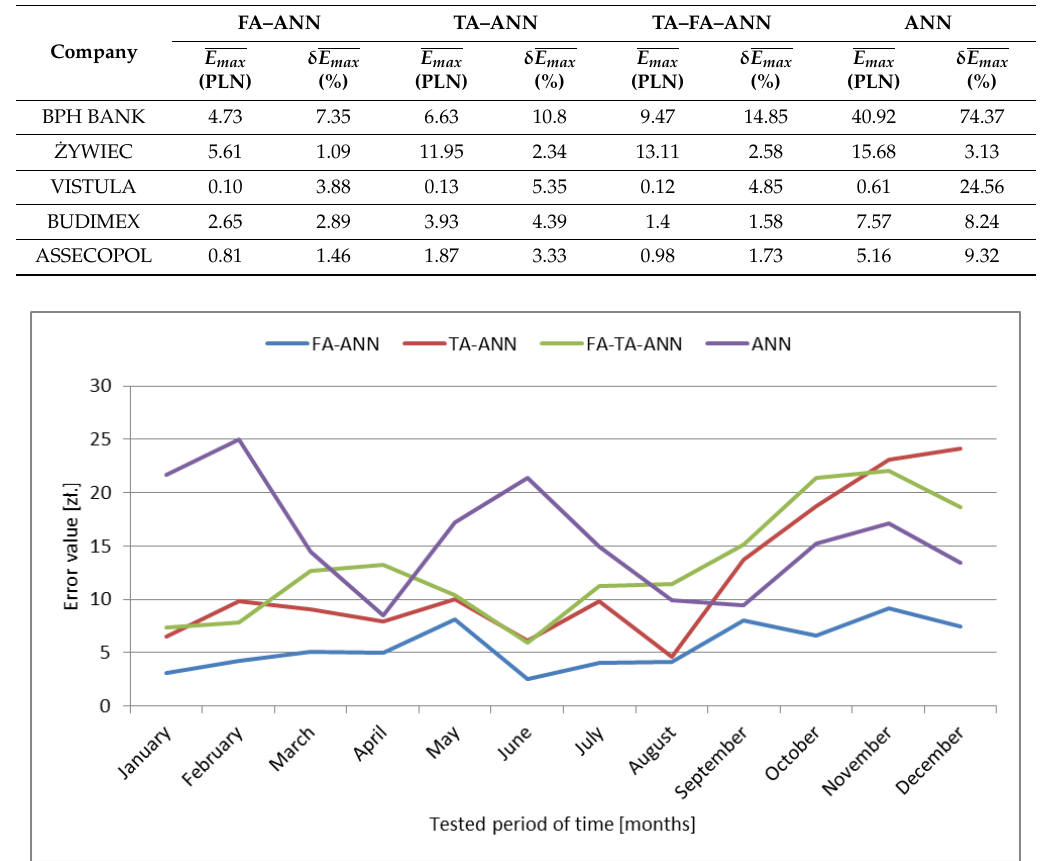
Figure 6. Comparison of E max values per month between all ANN-based models in a period of one year (2010) for ŻYWIEC SA.